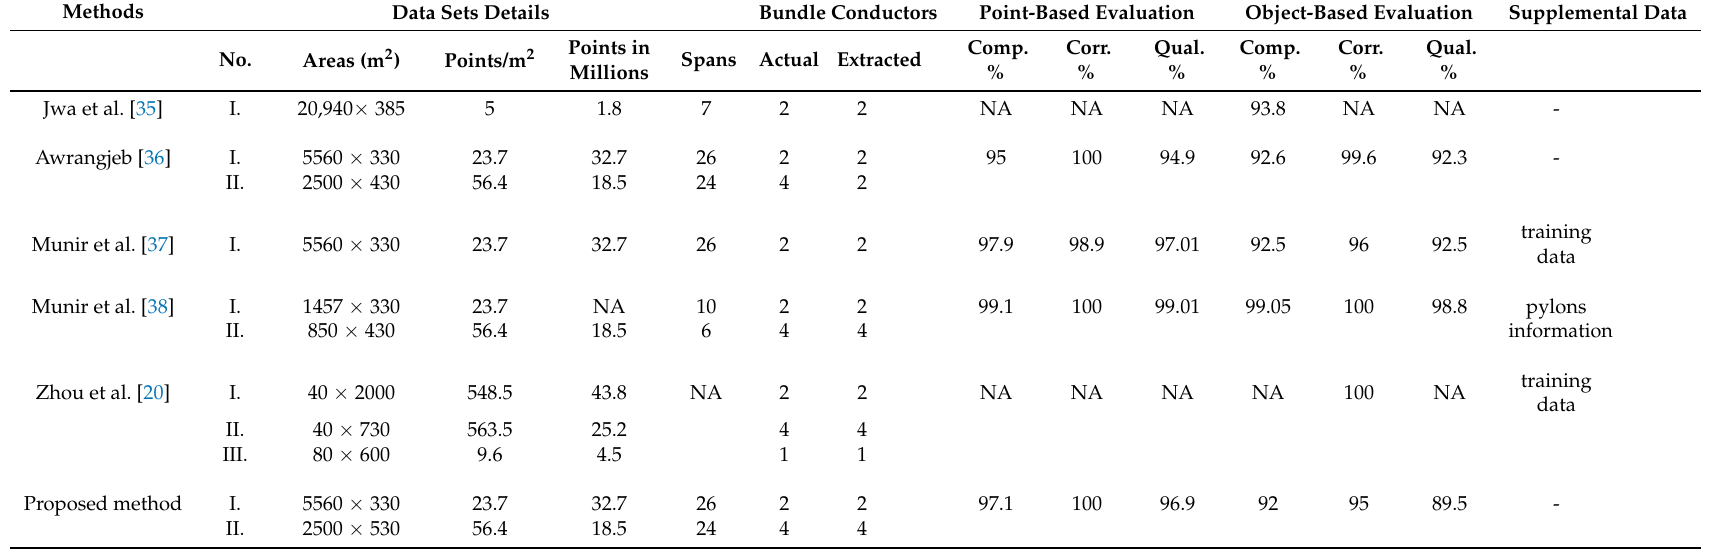
Table 10. Comparison of performance and evaluation with existing